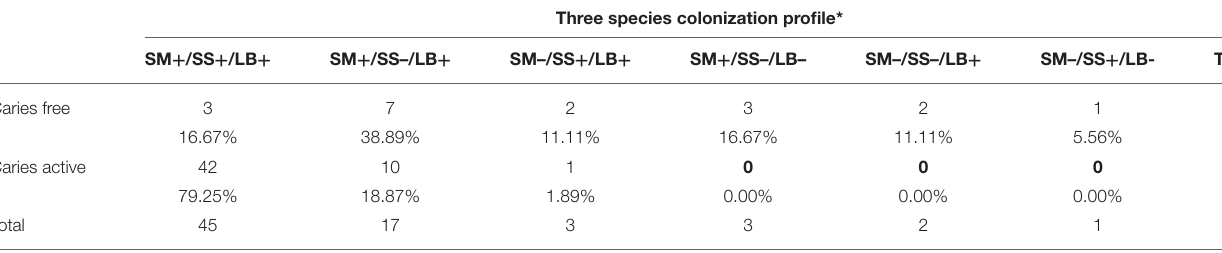
TABLE 3 | Distribution of three species colonization profiles in caries free and caries active children.